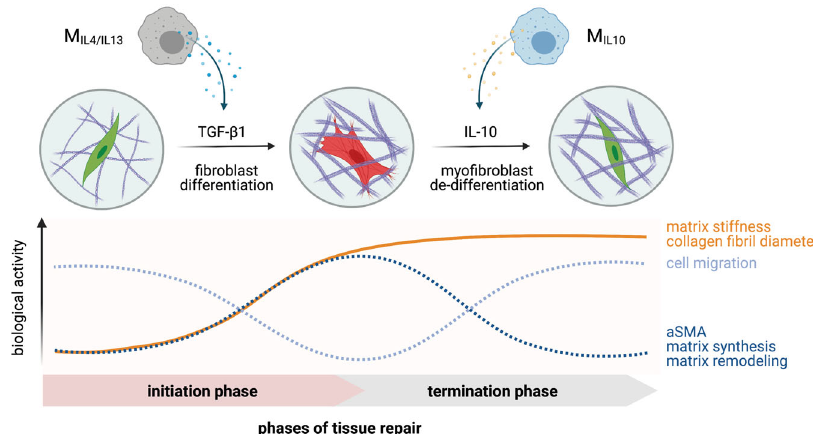
Fig. 9 Schematic illustration of the proposed M2-associated functions in initiation and termination phases of tissue repair in 3D biomimetic wound-healing model. M IL-4/IL-13 macrophages control the initiation of tissue repair by modulating fi broblast differentiation via TGF- β 1, while M IL-10 macrophages terminate the tissue repair by de-differentiating myo fi broblasts back into fi broblasts via